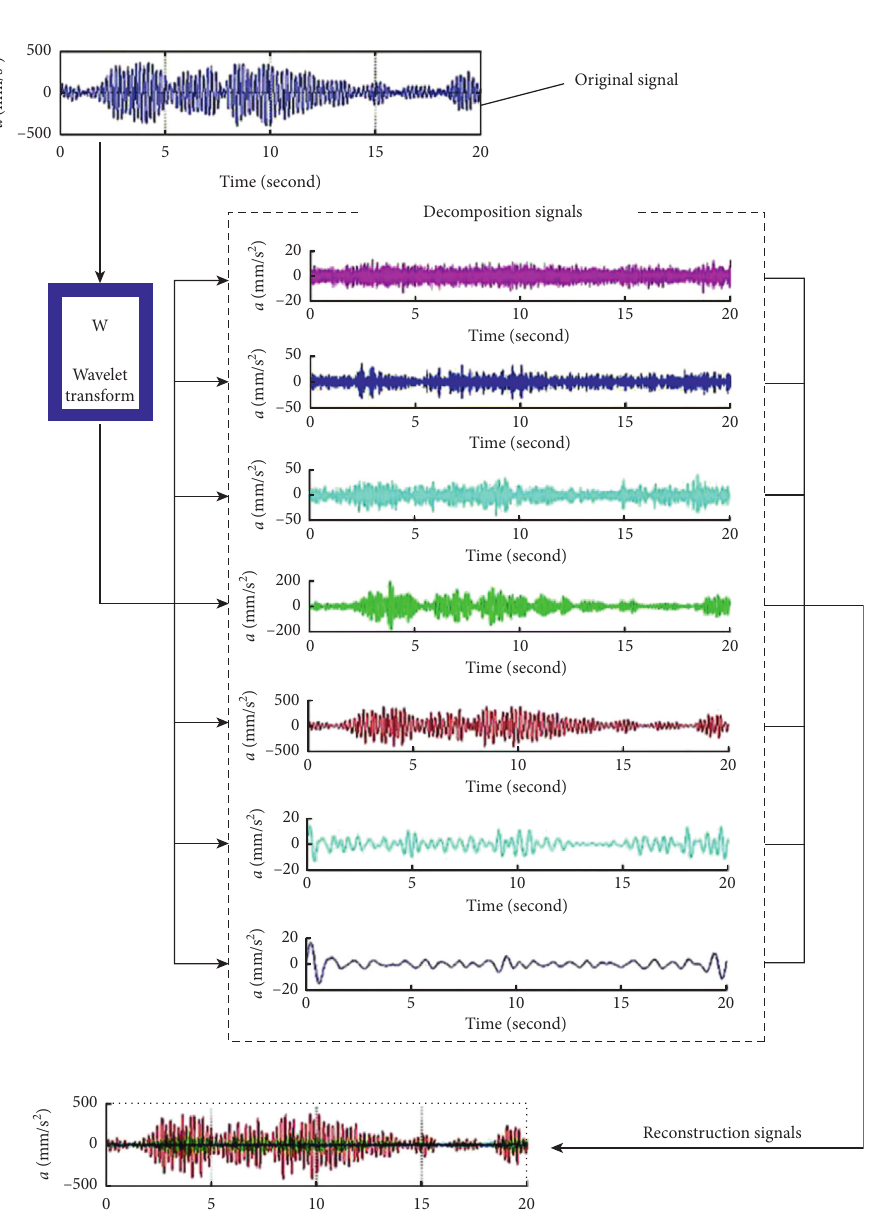
Figure 2: MODWT multiresolution analysis model [1].